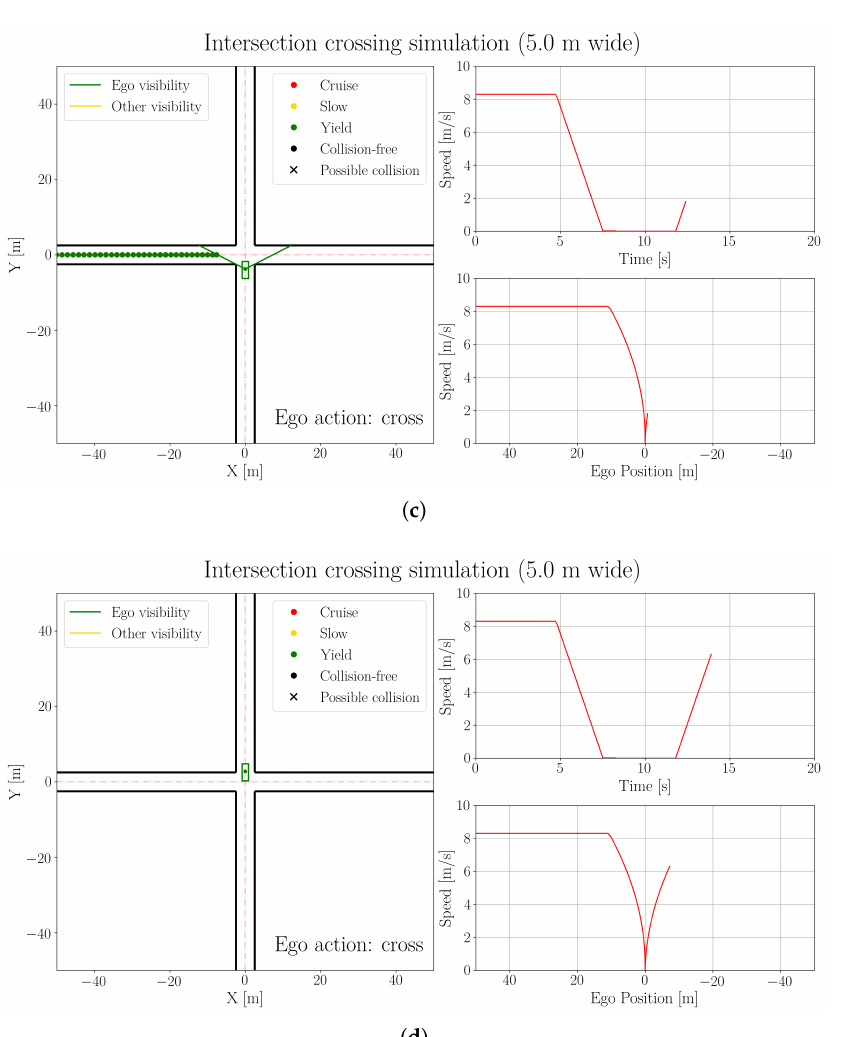
Figure 13. Examples of simulation results for the four stages of ego vehicle motion when crossing an occluded intersection. ( a ) The ego vehicle slows down and prepares to stop at the intersection’s entrance, as its visibility, shown by the green lines, is not sufficient for crossing. ( b ) The ego vehicle has come to a full stop right at the entrance of the intersection. Even though the ego vehicle’s visibility is still limited from this position, it can be observed by other vehicles from a distant location, as its front end is aligned with the intersection’s edge. ( c ) The ego vehicle begins to move into the intersection after it has stopped and estimated that other hidden vehicles have seen it waiting to cross. As a result of moving forward, the ego vehicle gains additional visibility of the intersecting roadway. ( d ) The ego vehicle makes a complete intersection crossing, as the visibility has become